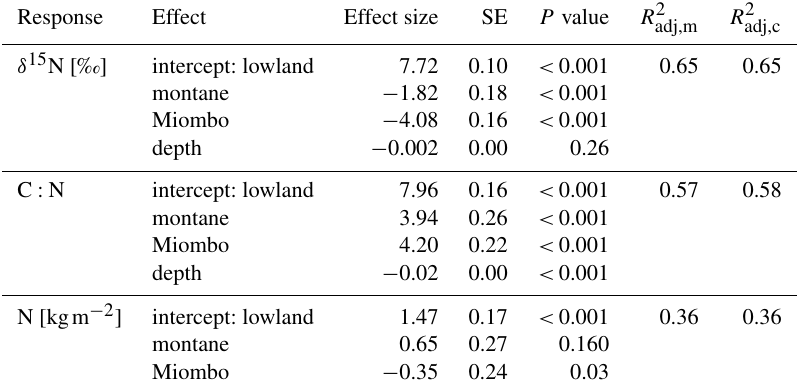
(Nakagawa and Schielzeth, adj